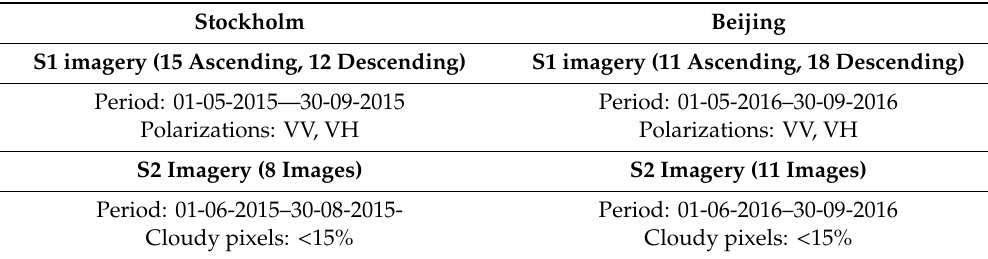
Table 2. Overview of the acquired satellite imagery